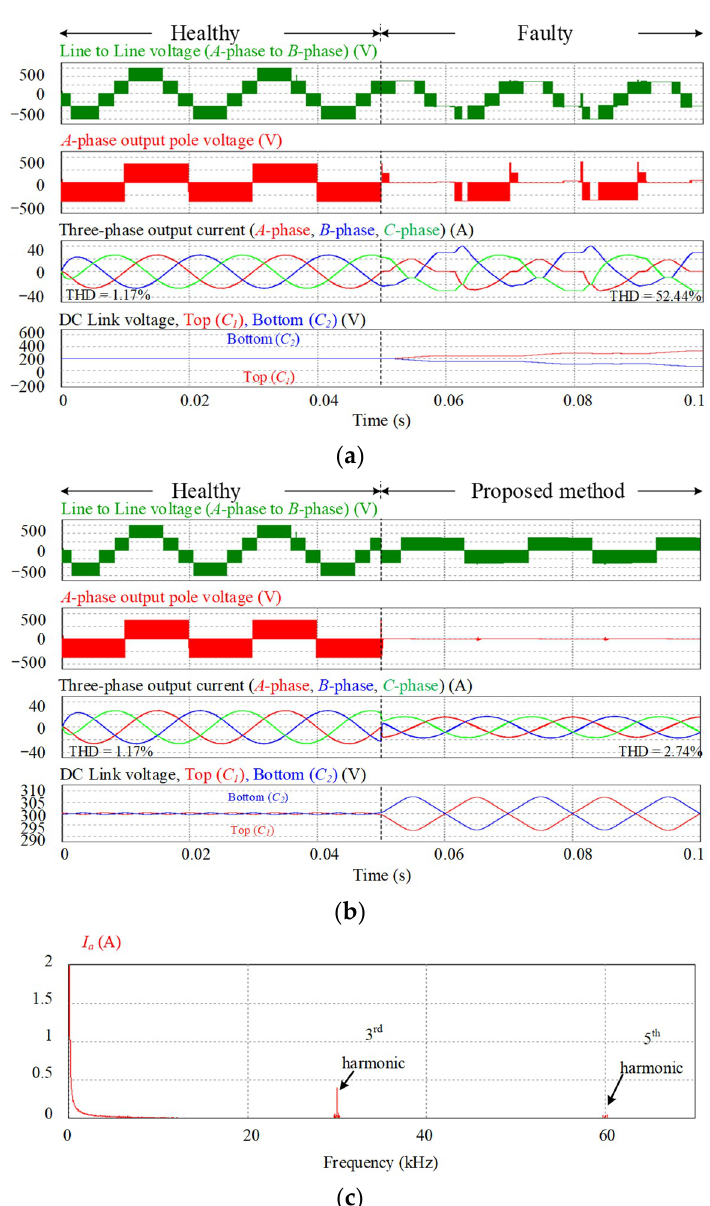
Figure 10. V ab , V an , three-phase currents, and DC link voltages when an open-circuit failure occurs at Q a1 / D Qa1 healthy and faulty conditions ( a ) before applying the proposed method, and ( b ) after applying the proposed method. ( c ) The corresponding harmonic distribution after applying the proposed method.